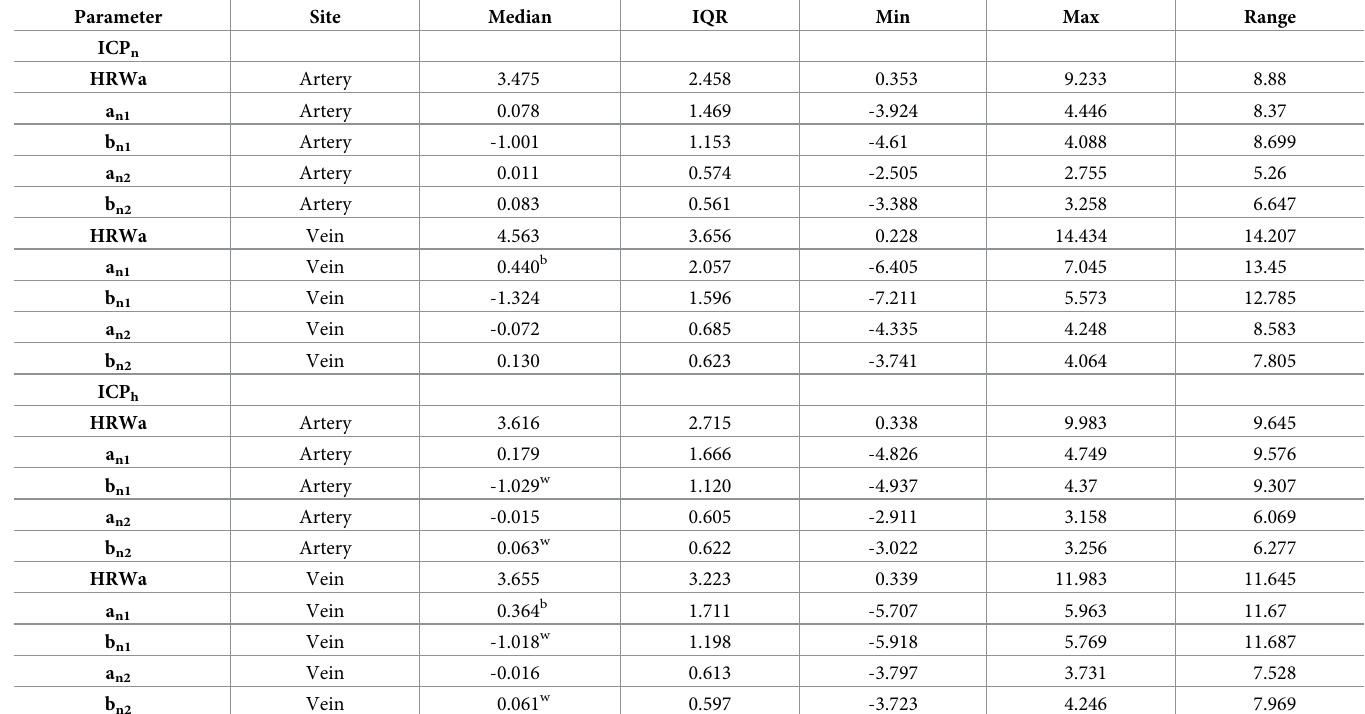
Table 2. Descriptive statistics.